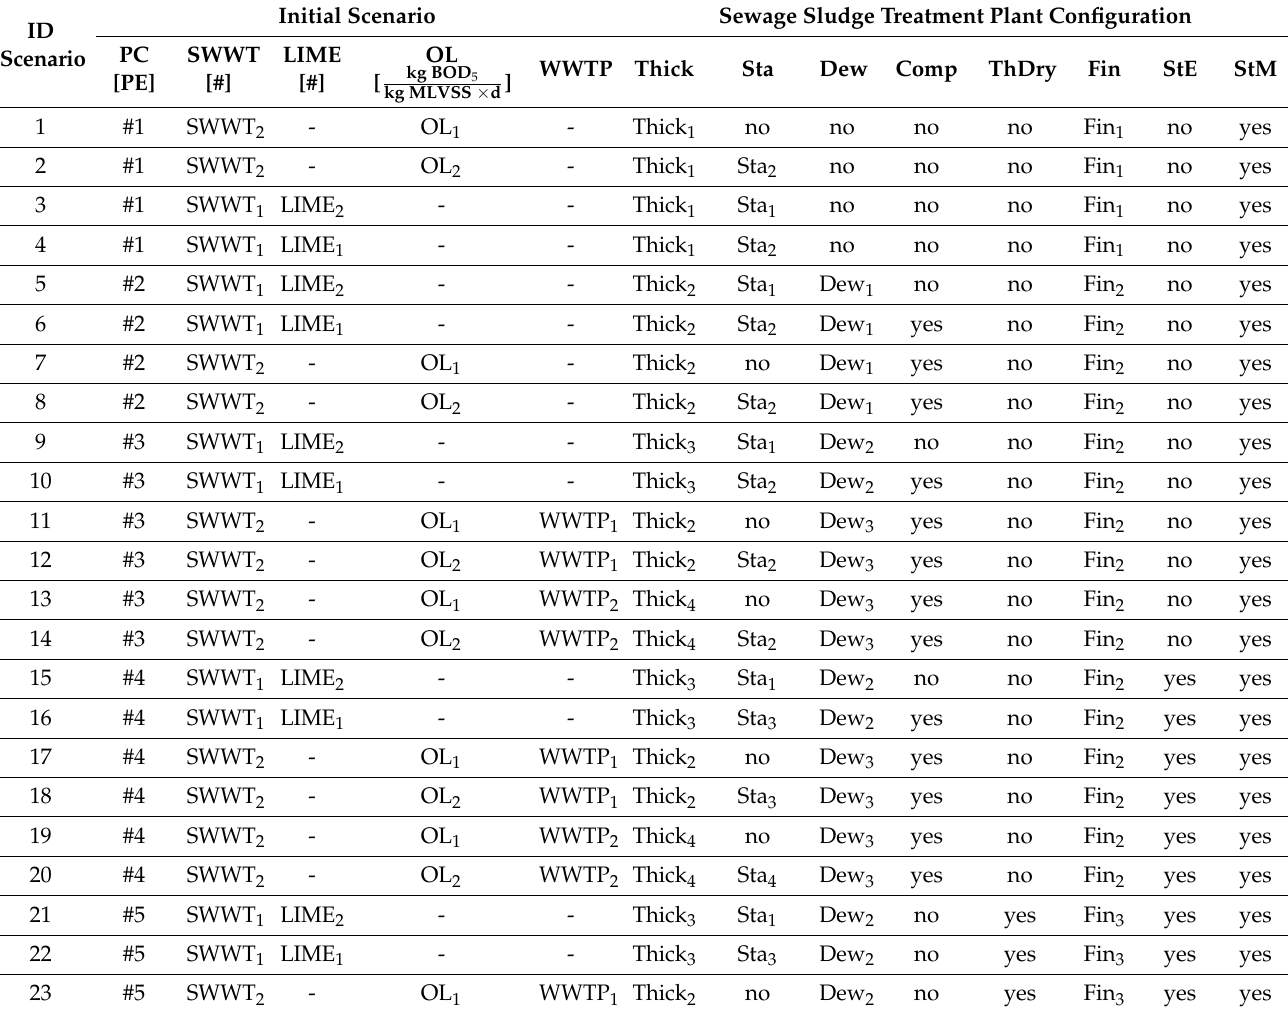
Table 4. Scenario analysis: summary of initial 26 scenarios vs. corresponding SSTP